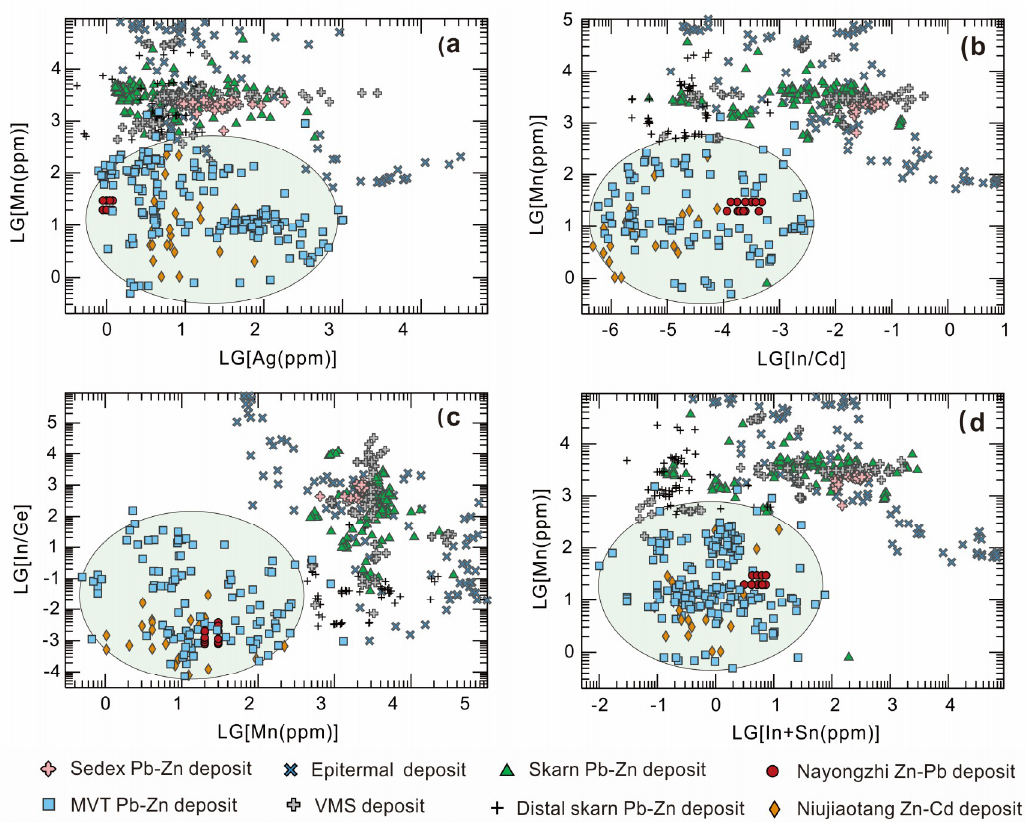
Figure 12. Binary plots of Ag vs. Mn ( a ), In/Cd vs. Mn ( b ), In/Ge vs. Mn ( c ), and In + Sn vs. Mn ( d ) in sphalerite from the Nayongzhi deposit and other Zn-Pb deposits in China, NE Europe, and Japan. Note: plots are based on data from Cook et al. [4] and Ye et al. [5,15].